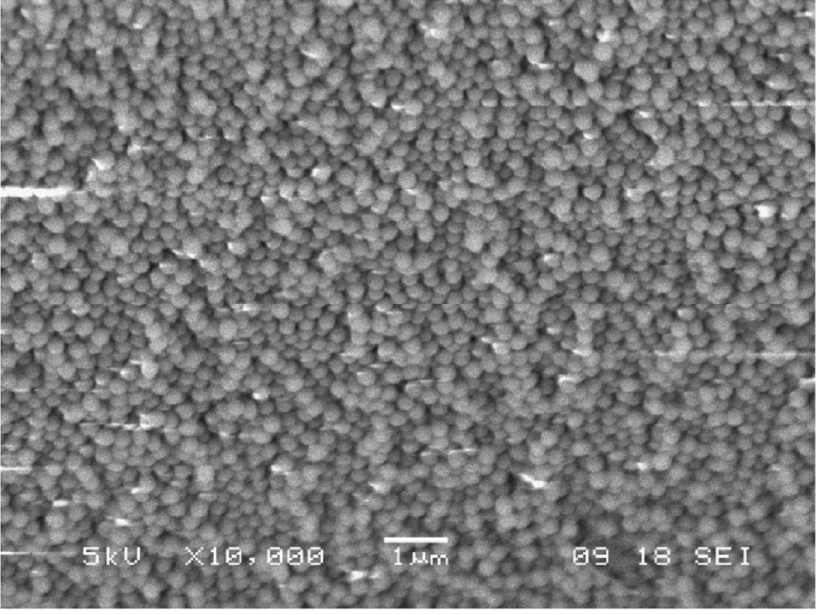
Figure 7. SEM image of the core-shell-like particles after seeded growth using the acid-based reaction. Particle size is again around 270 nm. Reproduced with permission from [72], copyright 2007, Elsevier.